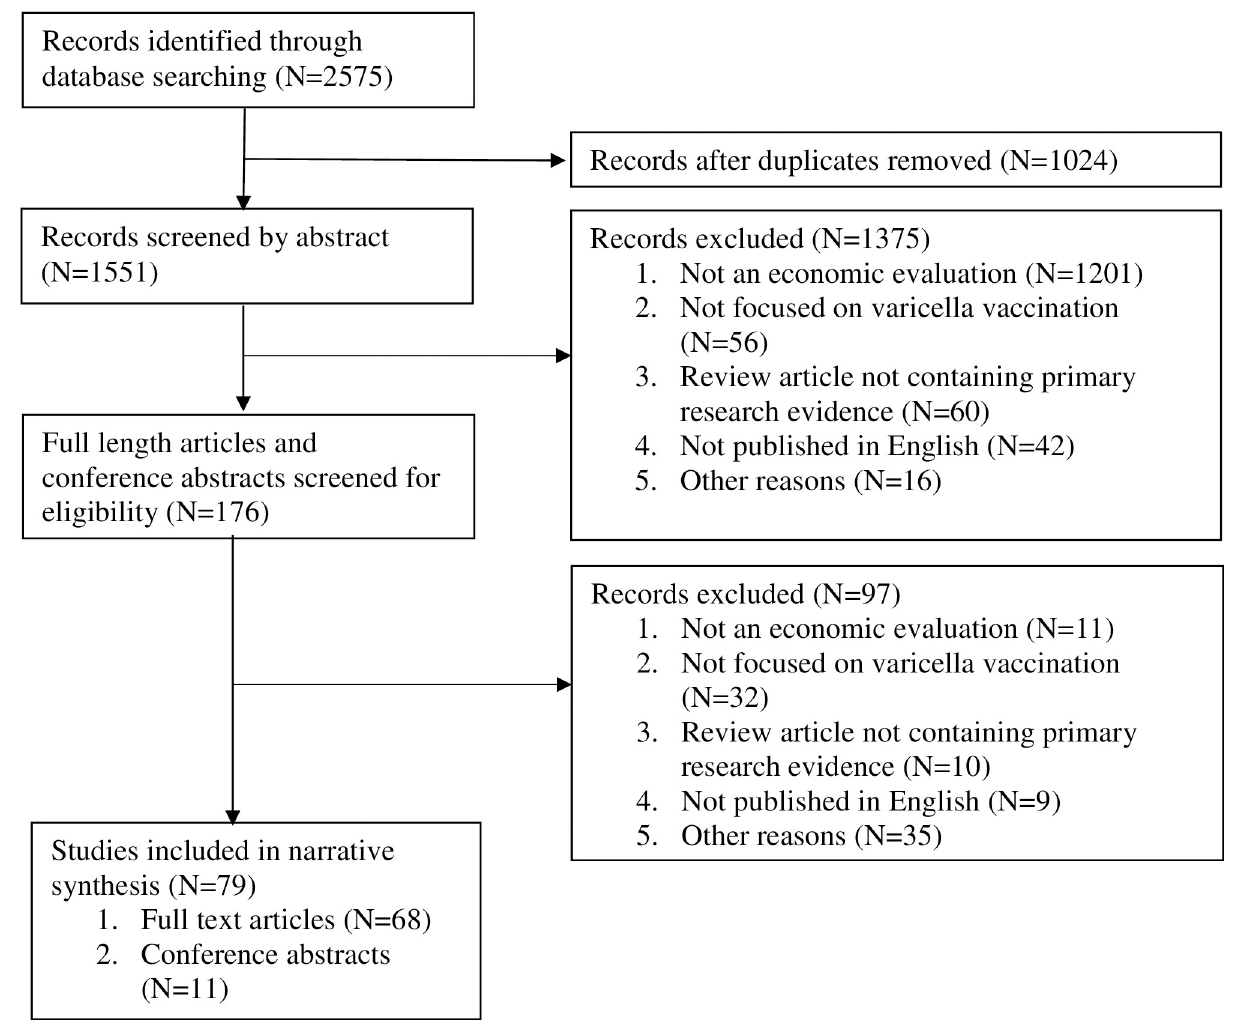
Fig 1. PRISMA flow